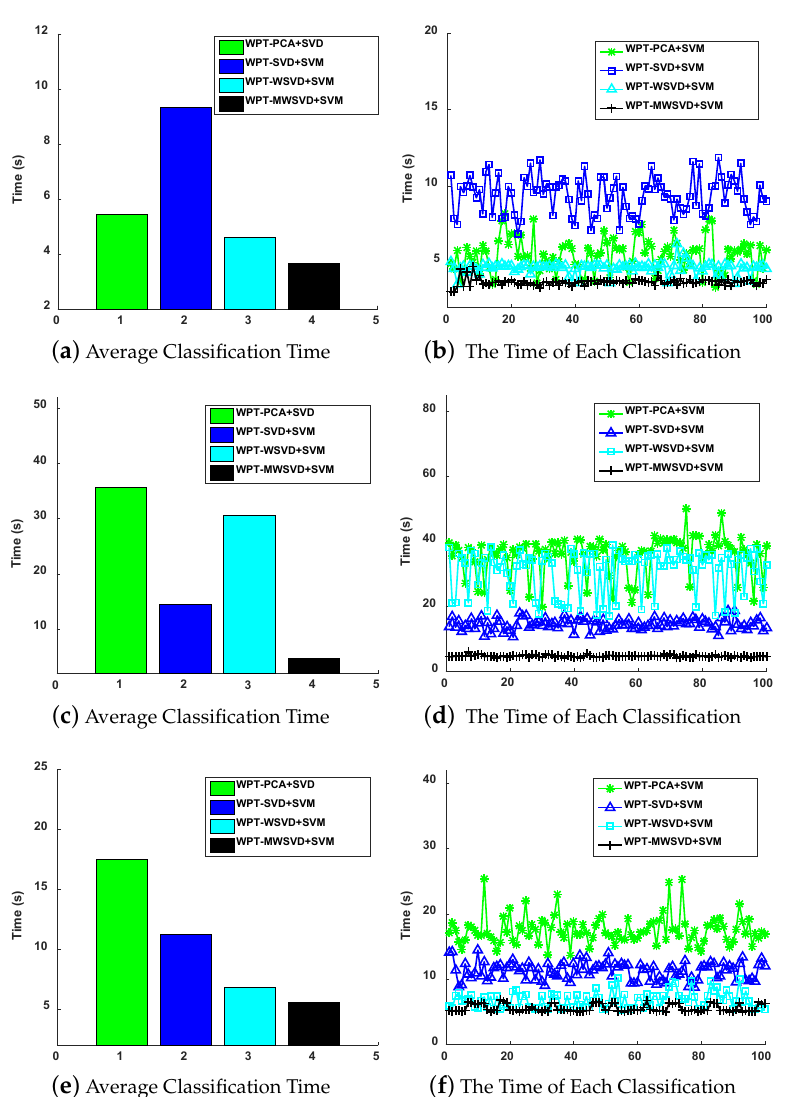
Figure 16. The degree of fault is minor fault ( a ), general fault ( c ) and serious fault ( e ); The degree of fault is minor fault ( b ), general fault ( d ), and serious fault ( f